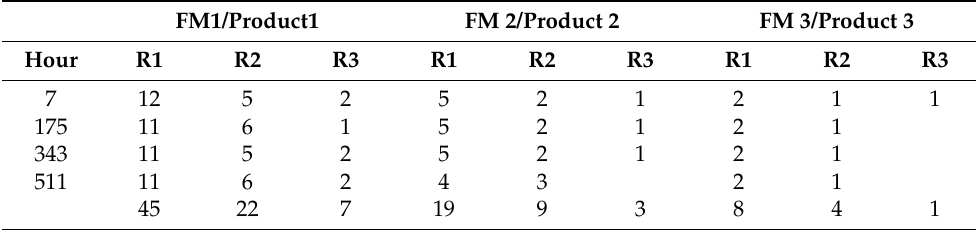
Table 6. Monthly orders record for the traditional